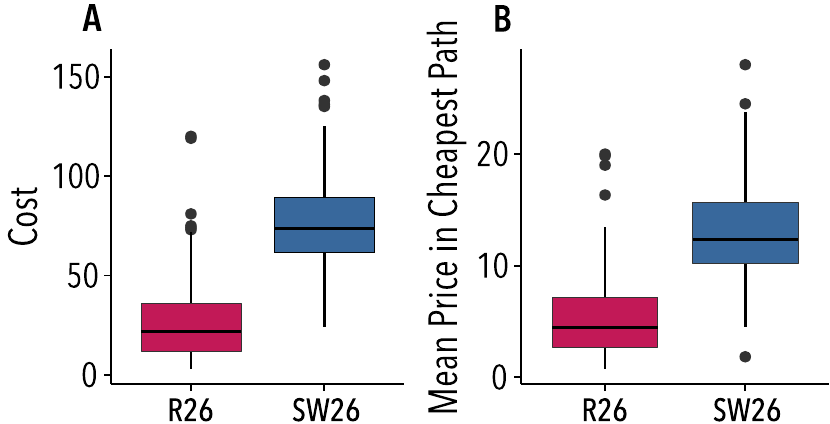
Figure 1. Network topology affects trading costs and prices. ( A ) Cost of the cheapest path for the random network of 26 nodes (R26), and for the small-world network of 26 nodes (SW26). ( B ) Mean price of participants in cheapest path for the same networks. Lines in the boxes denote the medians, whereas boxes extend to the lower- and upper-quartile values. Whiskers extend to the most extreme values within 1.5 interquartile range (IQR). Figure created using ggplot2 (v. 3.2.1) 21 .